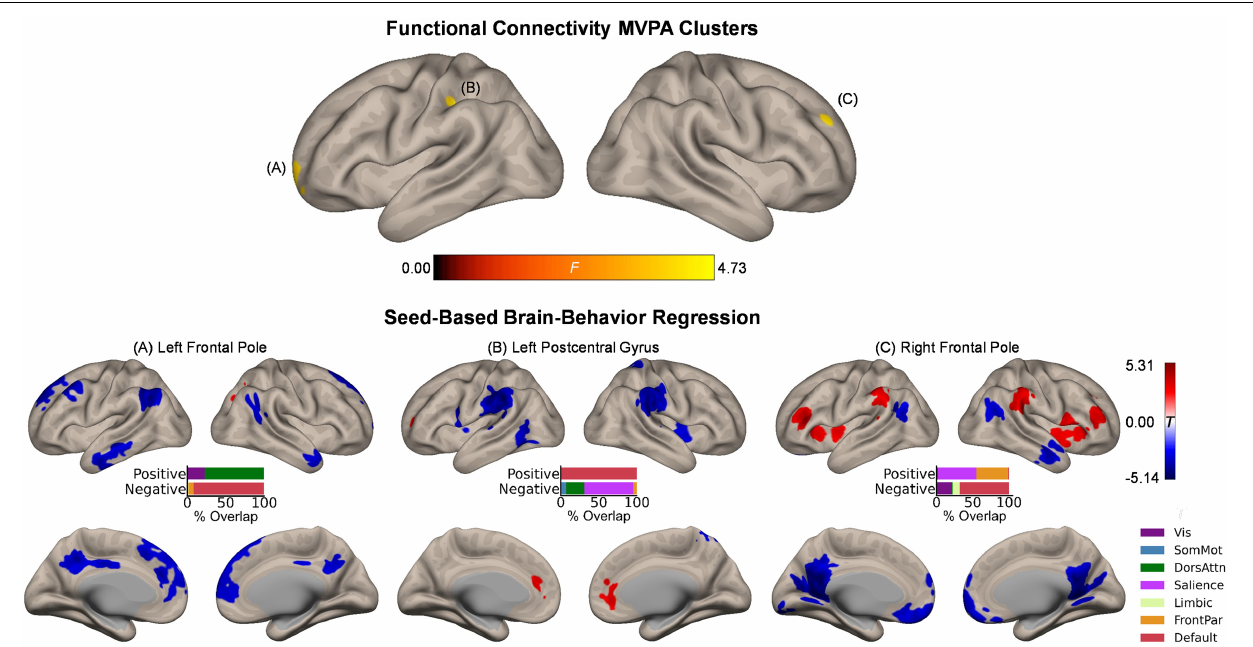
FIGURE 2 | Intrinsic functional connectivity correlates of item memory enhancement. (Upper panel) Clusters identified in the functional connectivity MVPA as being significantly associated with item memory enhancement. (Lower panels) Whole-brain correlation maps between seed connectivity and item memory enhancement. Bar graphs show the percentage of overlap between the areas identified in the correlation maps and canonical functional networks of the cerebral cortex (Yeo et al., 2011). Note that the voxel-wise intensity threshold for the correlation maps corresponds to | t | = 3.12 ( p ≤